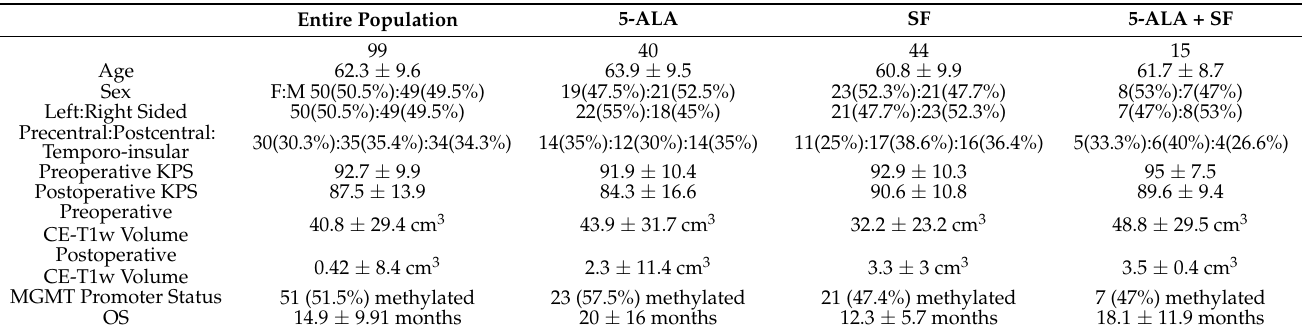
Table 1. Population characteristics. Entire population and subgroups are showed separately. Data are expressed as mean ± standard deviation for continuous variables, as frequencies and percentages for categorical